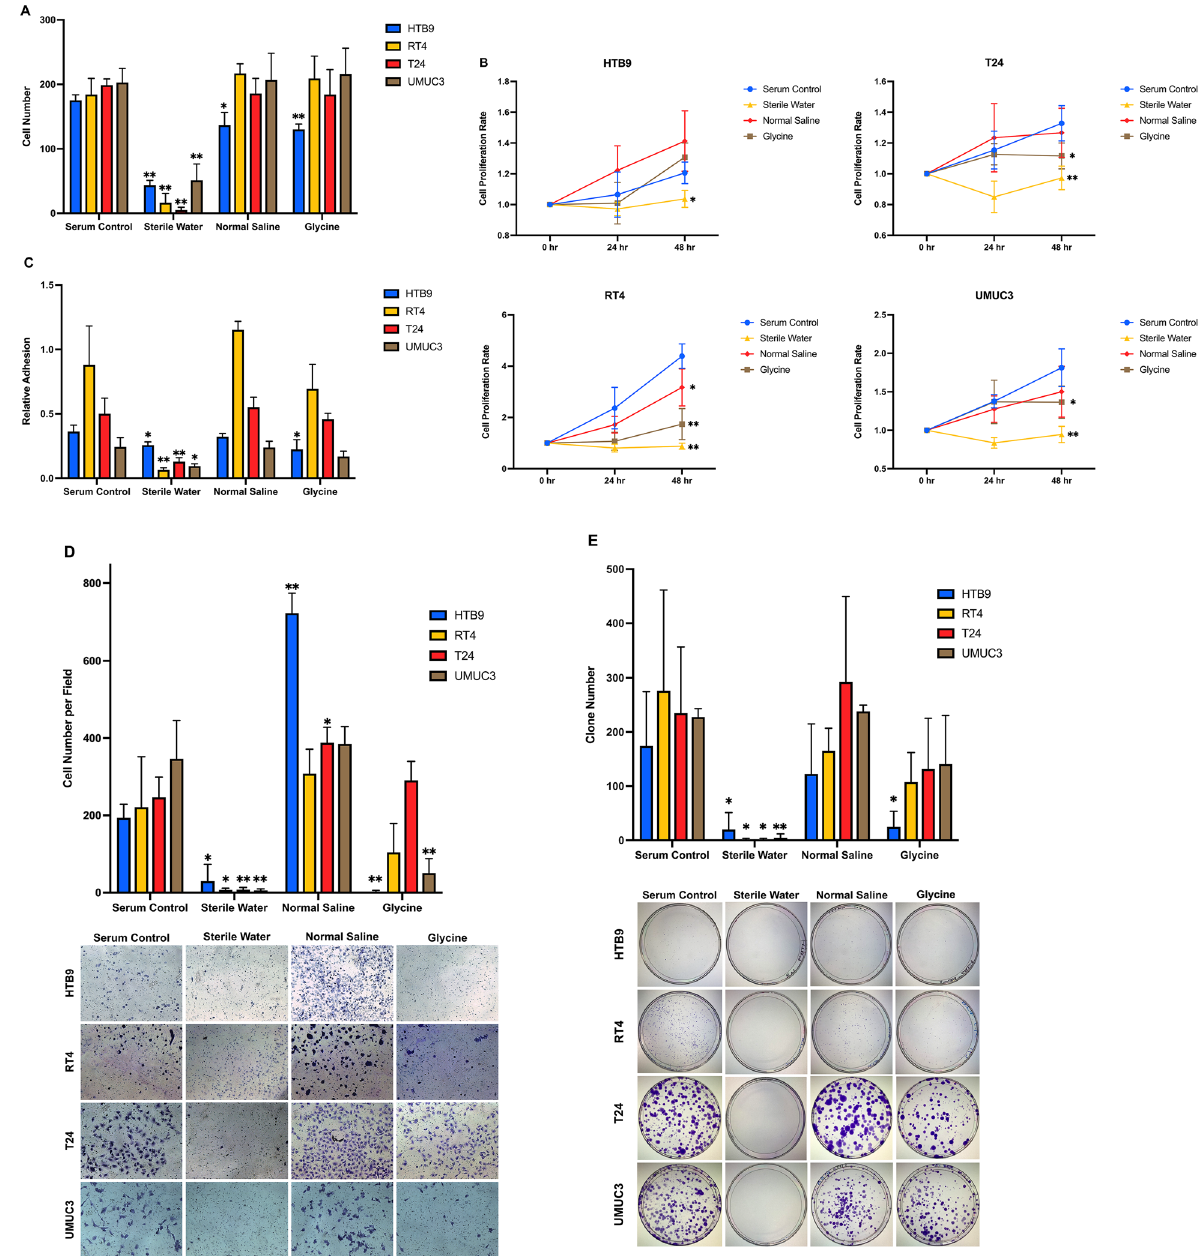
Figure 1. Identification of potential cytotoxicity of irrigation fluids. (A) Bladder cancer cell lines HTB9, RT4, T24 and UMUC3 were incubated in sterile water, normal saline or glycine for one hour. Total cell counts were quantified by trypan blue exclusion assay. (B) Cell proliferation rates were measured by MTT assays and presented as relative fold change to 0 h. (C) Cell adhesion ability were evaluated by measuring the attached cells by MTT assays and OD reading was proportional to the number of adhered cells. (D) Cell invasion assays were used to evaluate invasion capacity using the Matrigel invasion chambers. Cells invaded through the Matrigel layer were stained by crystal violet and counted using the ImageJ software. (E) Colonies formation abilities were determined by seeding 1000 living cells onto a 100 mm plate and incubated for 9 days. Colonies were then stained with crystal violet and colonies with more than 50 cells were counted. Data are presented as the mean ± SD. Different strategies were compared with serum control of the same cell line. *p < 0.05 and **p < 0.01, t test (n = 3, three independent biological replicates were performed for all the